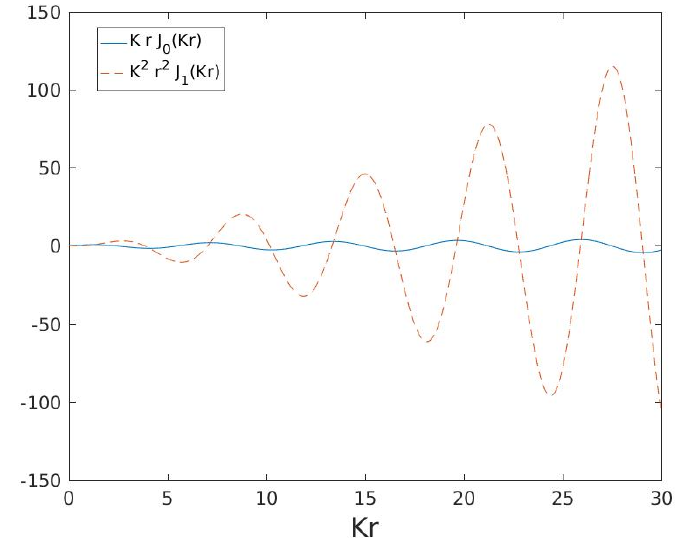
Figure 7. The “filter” function used in the spectrum reconstruction in (15) (dashed curve). Also shown is the function used in the alternate reconstruction in (4) (solid